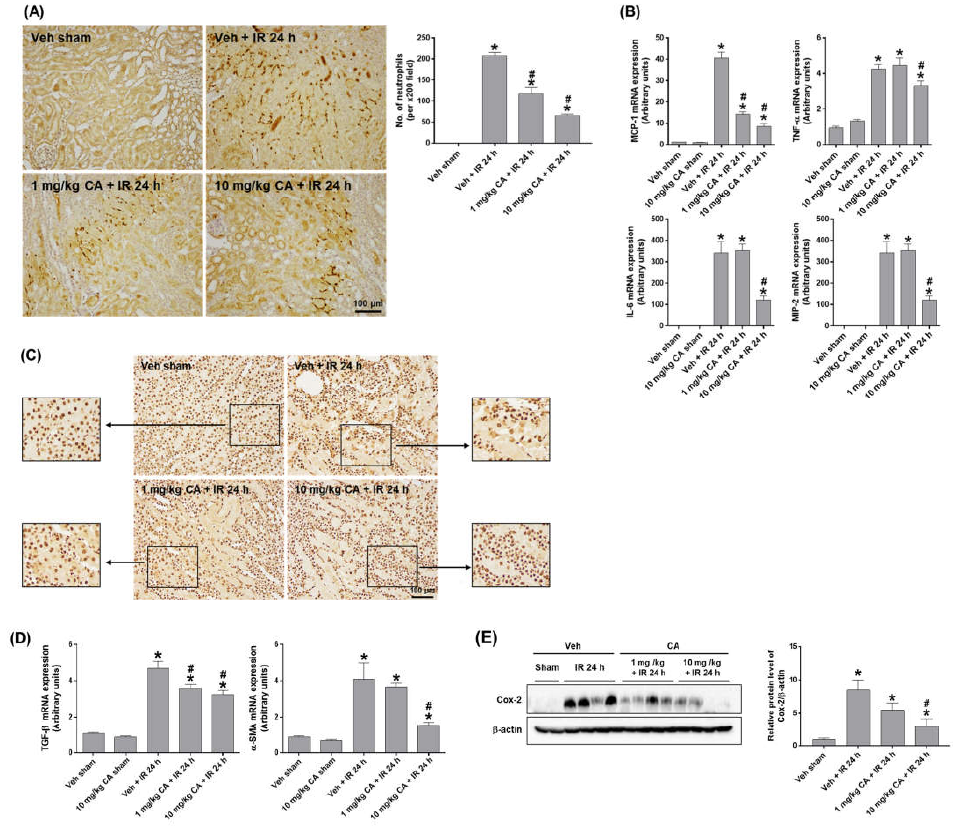
Figure 2. CA reduces neutrophil infiltration, inflammatory cytokines, and HMGB1 release in the kidney of IR mice. Representative images of polymorphonuclear leukocytes (PMN) staining of kidney sections; the positive cells were counted per ×200 field ( A ). Renal mRNA expression of pro-inflammatory genes, MCP-1, TNFα, IL-6, and MIP-2; relative mRNA levels were normalized to levels of GAPDH ( B ). Representative images of HMGB1 immunohistochemical staining of kidney sections ( C ). Renal mRNA expression of profibrotic genes, TGF-β, and α-SMA; relative mRNA levels were normalized to levels of GAPDH ( D ). Western blots showing the bands of COX-2 in kidney tissue lysates; relative protein levels were normalized to levels of β-actin ( E ). The values are expressed as the means ± SEM. * p < 0.05 compared to sham group. # p < 0.05 compared to IR group.